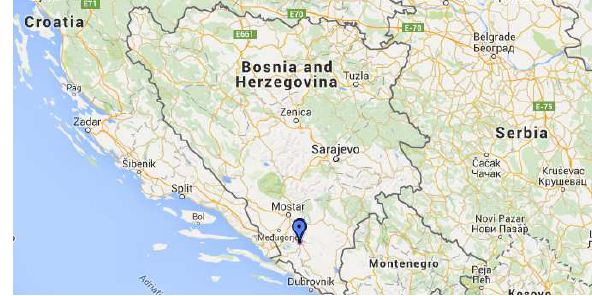
Figure 1 – Map showing the location of Stolac, BiH